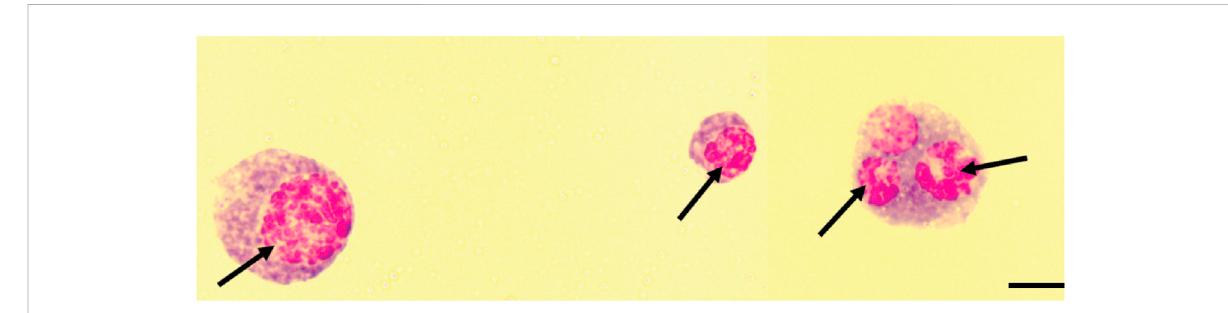
FIGURE 7 Karyorrhexis-like aggregation of the nuclei of host hemocytes. Black arrows indicate fragmented nuclei, Scale bars = 10 μ m.